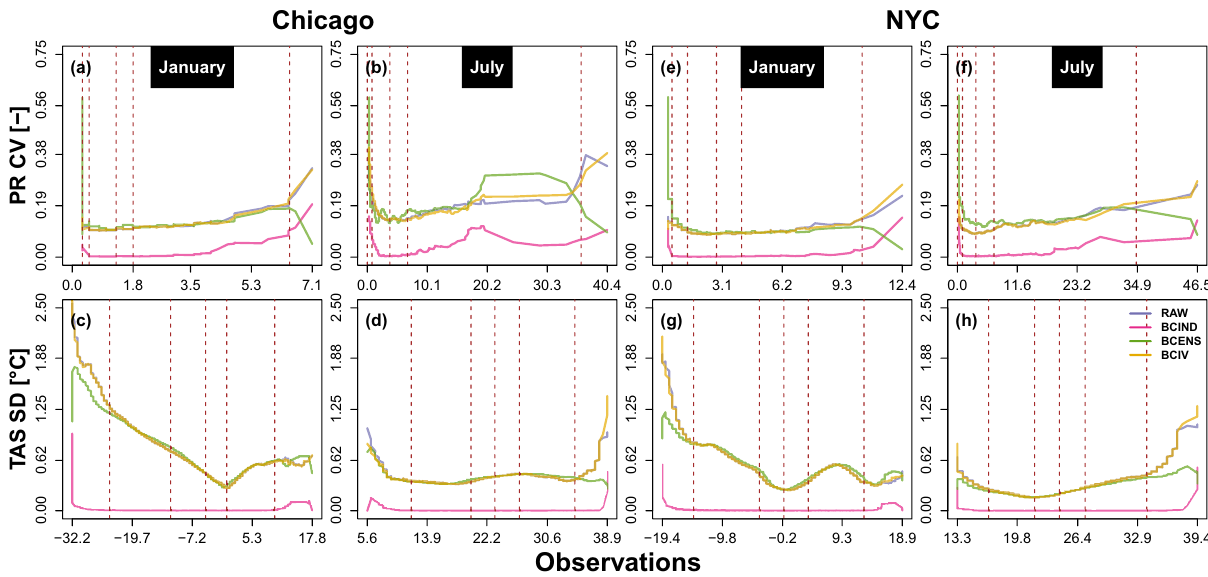
Figure 4. Precipitation CV (top) and temperature SD (bottom) of the simulated hourly quantile associated to the same probability over the 1961–1990 period of in function of the observed quantiles associated to the same probability at Chicago ( a – d ) and New York ( e – h ) for January ( a , c , e , g ) and July ( b , d , f , h ). The blue, purple, green and yellow solid lines represent respectively the raw and the BCIND, BCENS and BCIV corrected ensembles. Vertical dashed lines represent the observed 95th, 97.5th, 99th, 99.5th and 99.99th precipitation percentiles and the first, 25th, 50th, 75th and 99th temperature